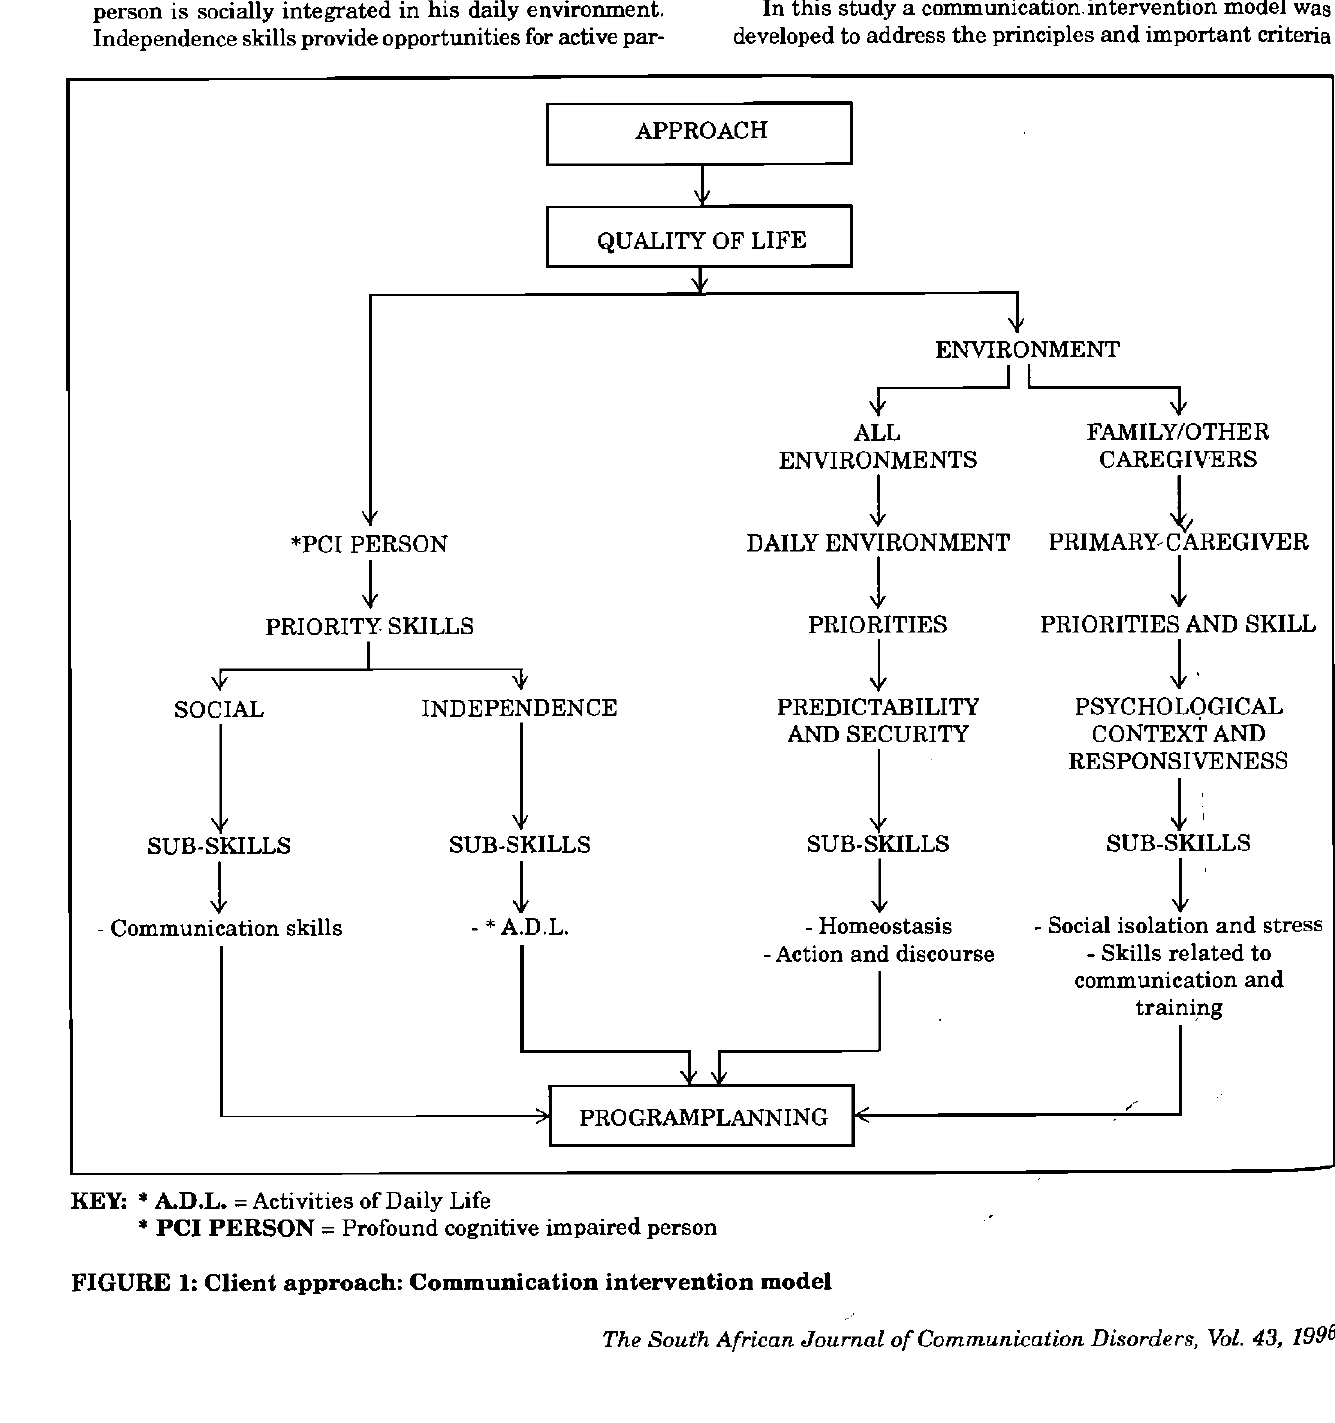
KEY: * A.D.L. = Activities of Daily Life